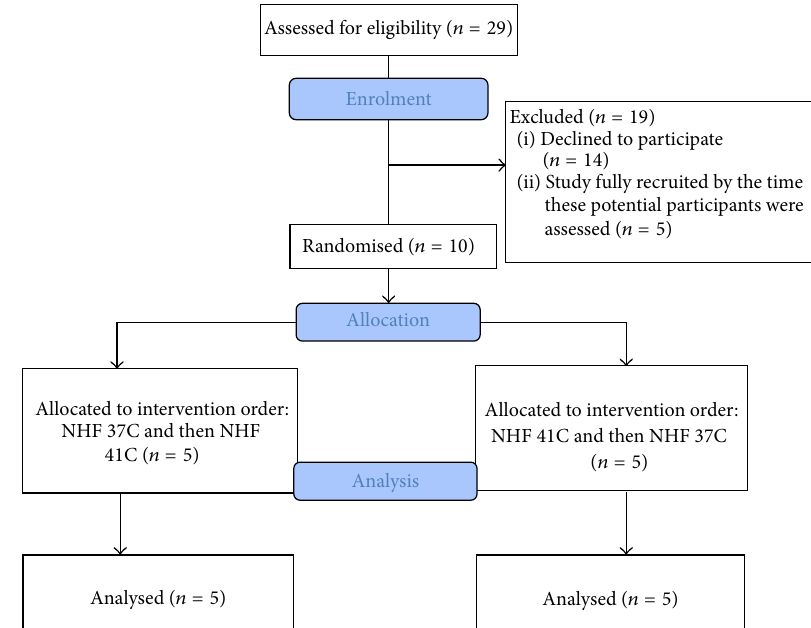
Figure 2: Flow of participants through the study.